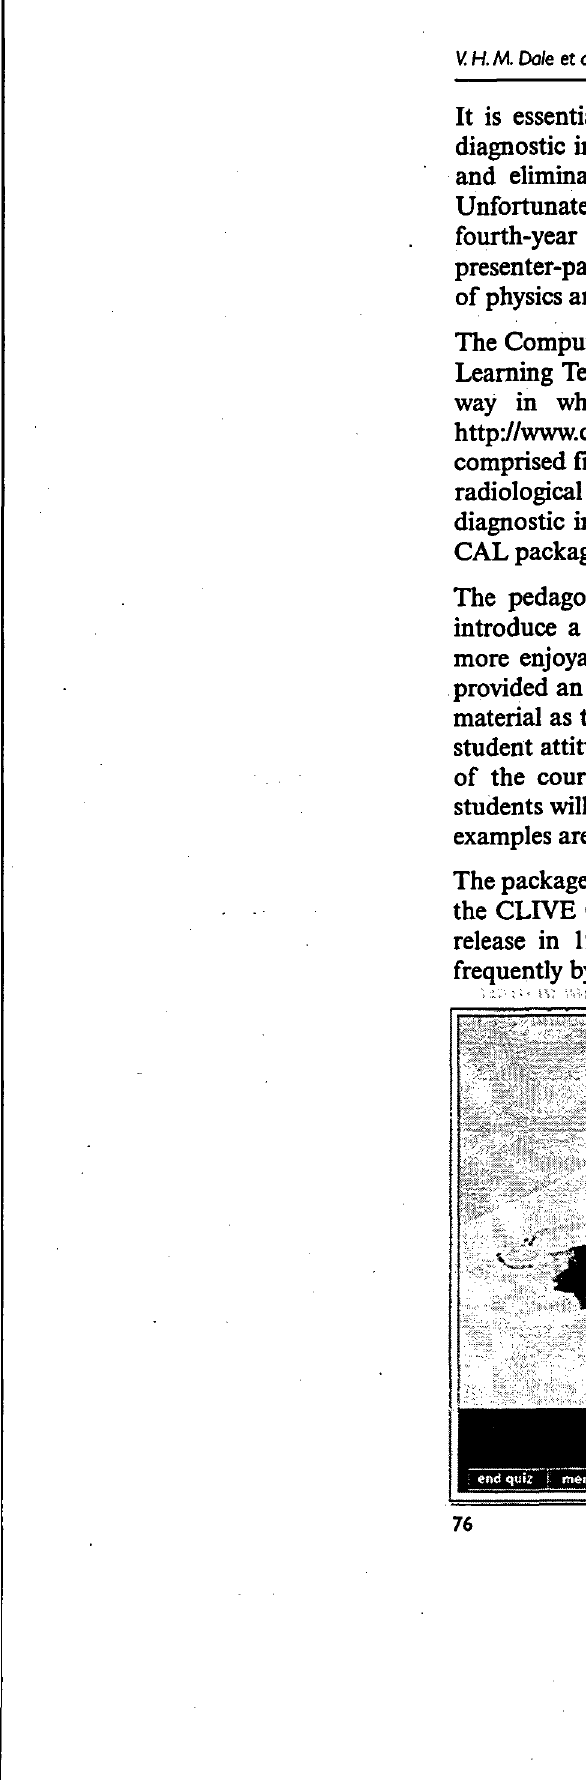
figure /: The QA module dlowing students to test thdr knowledge of radiological